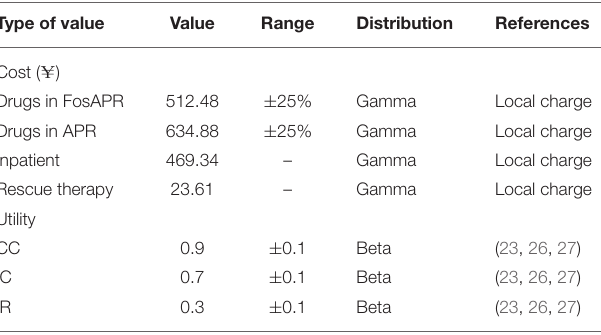
TABLE 3 | Costs and utility values in the